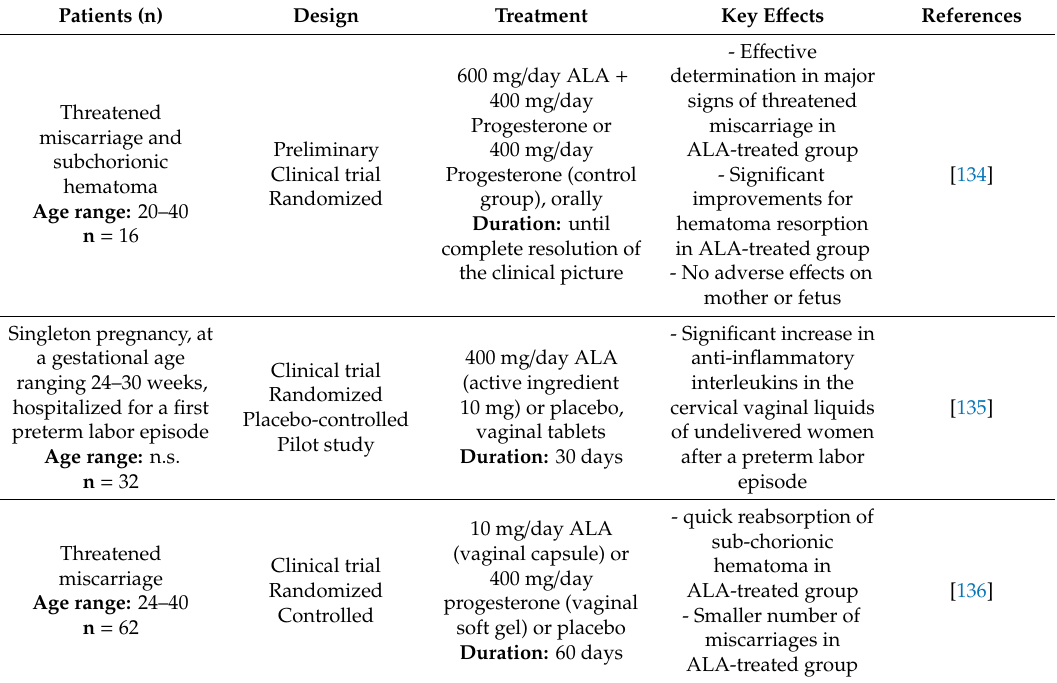
Table 5. E ff ects of ALA on abnormalities in